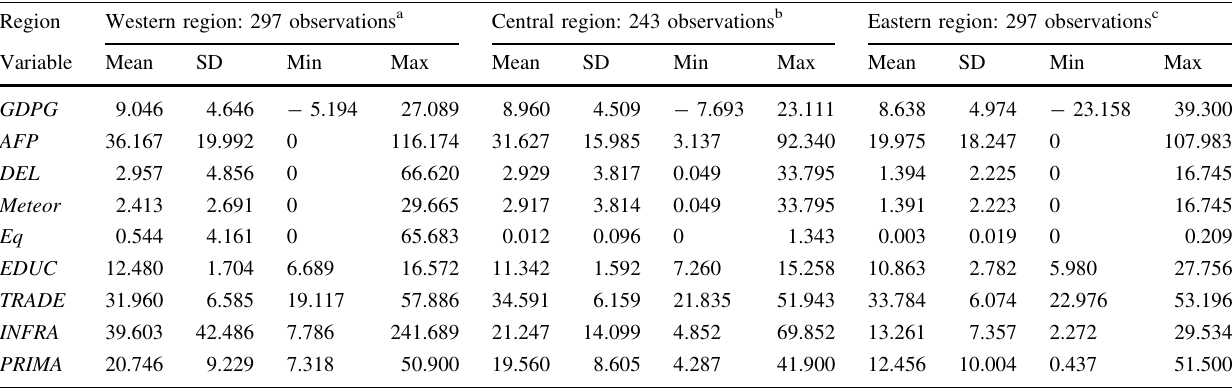
Table 2 Descriptive statistics for the variables in the study on macroeconomic consequences of natural hazard-induced disasters in China, 1990–2016